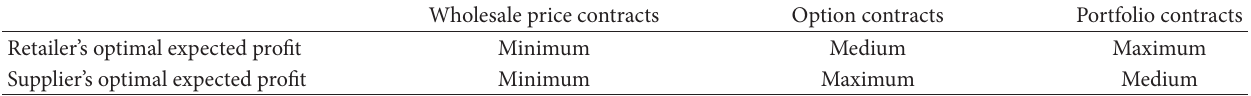
Table 2: The impact of option contracts on supply chain